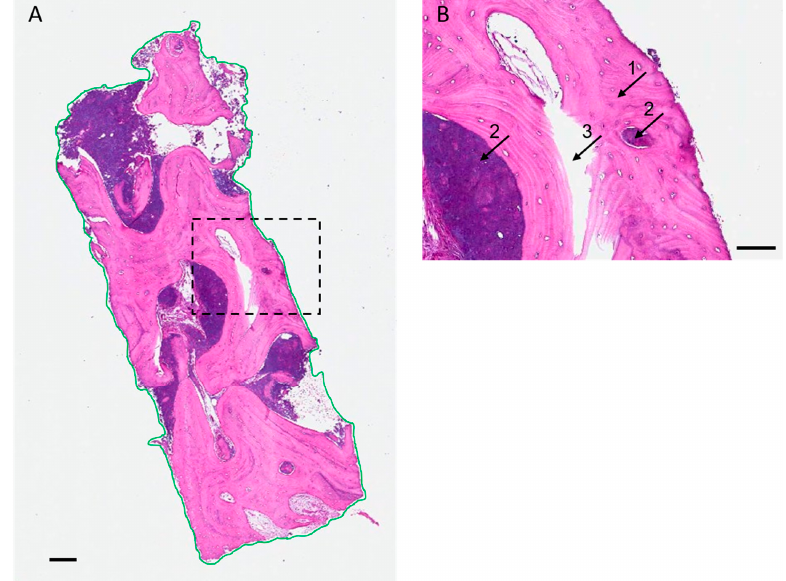
Figure 3. Image of a representative histologic sample taken from a socket grafted with EDEBEX and stained with hematoxylin-eosin. The biopsy was collected from the patient whose surgery is shown in Figure 2. Panel A shows the sample at 2.5× magnification, and the green line highlights how the total area of the sample was calculated for the histomorphometric analysis. Scale bar, 200 µm. Panel B shows the area bounded by the dashed line in panel A at higher magnification (12×). Arrow 1 indicates an area of newly formed bone (NBA), arrow 2 indicates residual biomaterial (RB), and arrow 3 indicates marrow space. Scale bar, 100 µm.